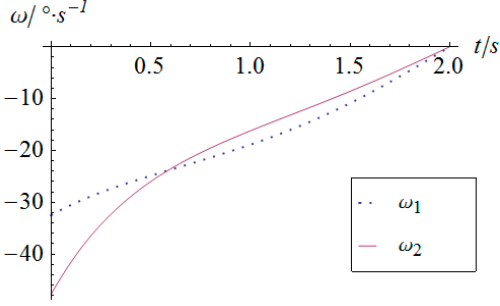
Figure 8. Angular velocity vs. time of the actuators.